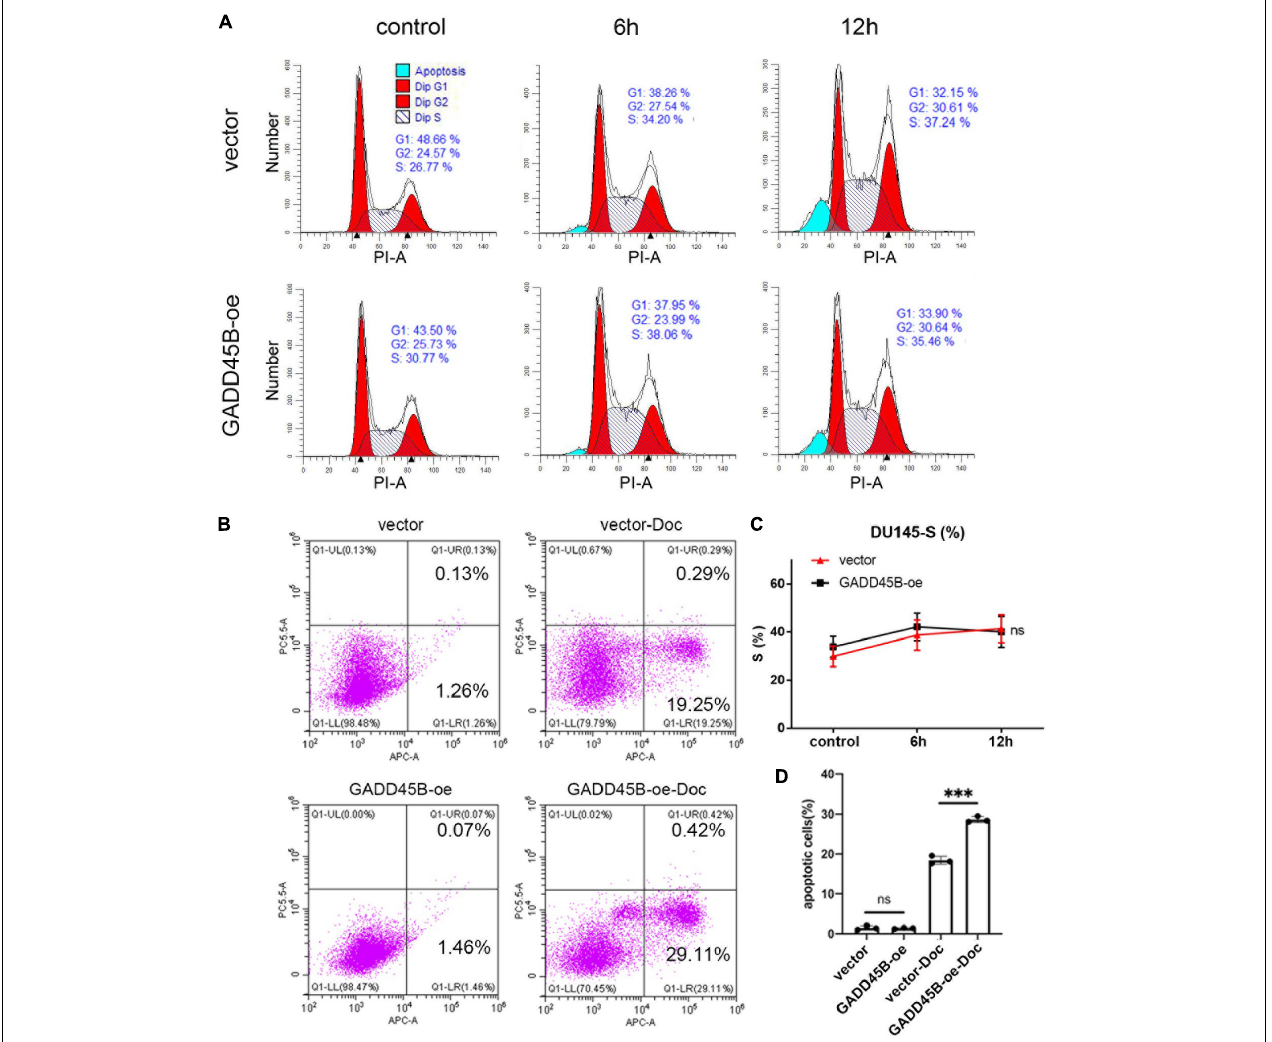
FIGURE 6 | GADD45B promoted chemotherapy sensitivity by regulating cell apoptosis. (A,C) Representative flow cytometry cell cycle images and statistical analysis of DU145 cells before and 6 and 12 h after chemotherapy. (B,D) Representative images and histogram analysis of flow cytometry on apoptosis of DU145 cells before and 48 h after chemotherapy. *** p < 0.001 and not statistically significant p >